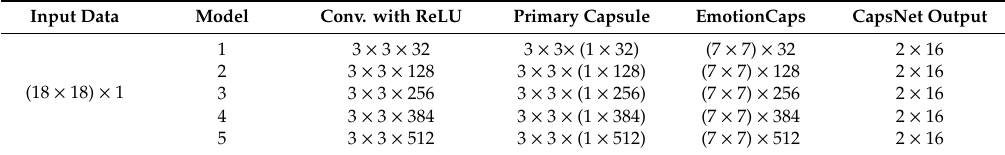
Table 2. Five CapsNet-based models with di ff erent parameters in the first